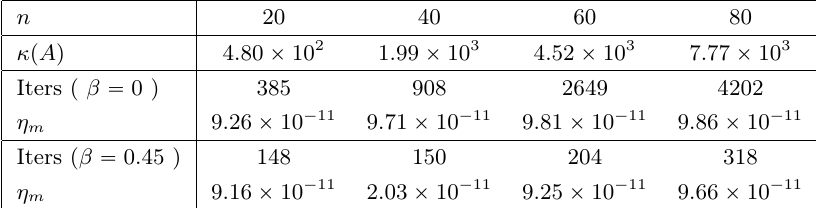
Table 1. Numerical results for Example